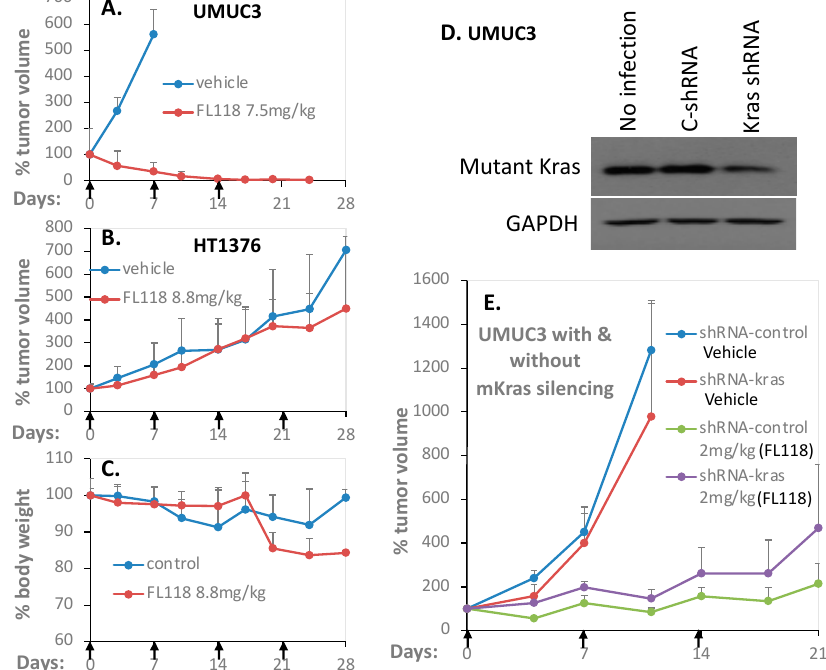
Figure 9. Antitumor efficacy of FL118 in severe combined immunodeficiency (SCID) mice bearing human bladder cancer xenograft tumors. The human bladder cancer xenograft tumors were first generated through implanting bladder cancer cells at the flank area of SCID mice. Then, the tumors were isolated, and individual experimental mice were subcutaneously implanted with 30–50 mg nonnecrotic tumor masses at the flank area of individual mice. Seven to 14 days after tumor transplantation at which the implanted bladder xenograft tumors were grown to 100–150 mm 3 (defined as day 0), mice were randomly divided into the required groups (5 mice per group) for treatment vial oral administration of FL118 at the doses as shown or vehicles with a schedule of weekly × 3 or 4 (arrowed) as described in the “Materials and Methods” section. ( A ) FL118 efficacy against UMUC-3 bladder cancer cell-established xenograft tumors in SCID mice. ( B ) FL118 efficacy against HT1376 bladder cancer cell-established xenograft tumors in SCID mice. The tumor growth curves shown in A and B are the mean ± SD derived from 5 mice. ( C ) SCID mouse body weight changes after treatment with vehicle or with FL118. The mouse body weight curves shown in C are the mean ± SD derived from 5 mice. ( D ) Western blots validate the expression of mutant Kras in UMUC3 cells in the condition of no infection, with control shRNA lentiviral particle transfection or with Kras shRNA lentiviral particle transfection (Of note, this is the stably infected multiple-infectant mixture, which usually had the issue with some endogenous mutant Kras, due to some unclear reasons). GAPDH is the internal control. ( E ) FL118 exhibited was less effective in inhibiting UMUC3 tumors with a partial silencing of mutant Kras using Kras shRNA. The tumor growth curves shown in E are the mean ± SD derived from 5 mice. 4. Discussion In order to facilitate a better discussion of the studies reported in this paper, we must first briefly introduce the discovery and the previous findings on FL118. We have generated the survivin promoter-driven luciferase reporter-stably expressed cancer cell models from the colon (HCT116), lung (A549), breast (MCF-7), prostate (PC-3) and ovary (2008) cancer cells [53]. Using these genetically engineered cancer cell models through high throughput screening (HTS) of compound libraries, followed by hit-to-lead in vitro and in vivo testing, we identified the novel small molecule anticancer drug FL118 [16]. We found that FL118 inhibits multiple anti-apoptotic proteins in the